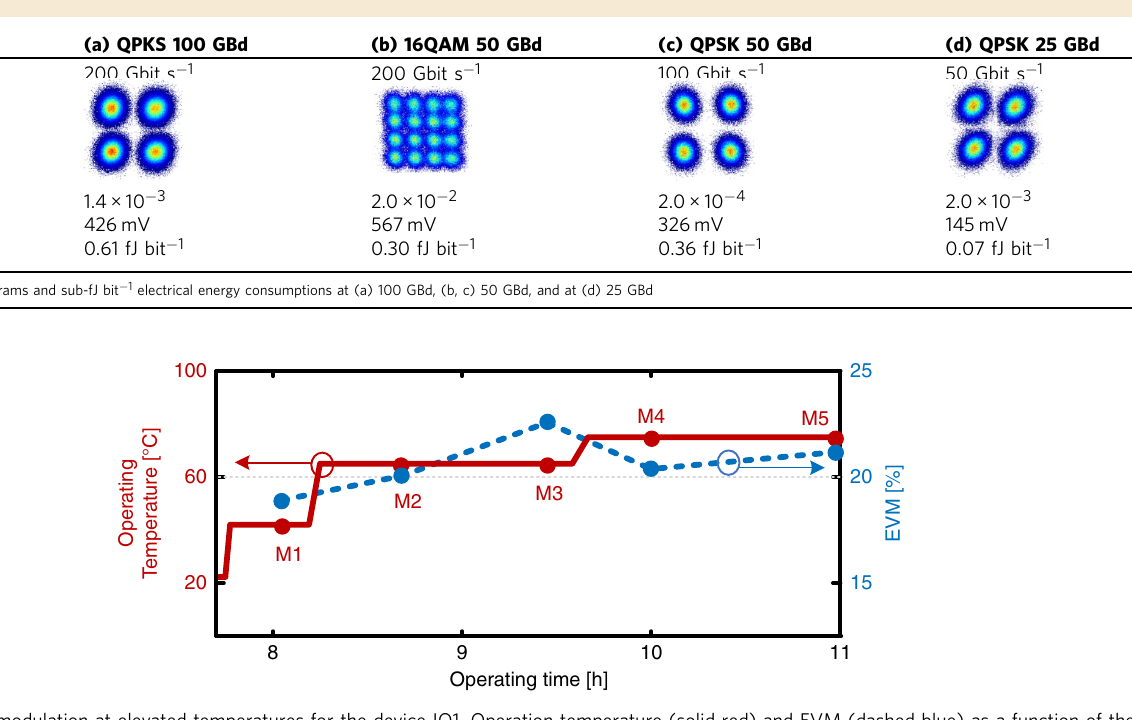
Table 2 Device operation with sub-1 V driving electronics without driving ampli fi er